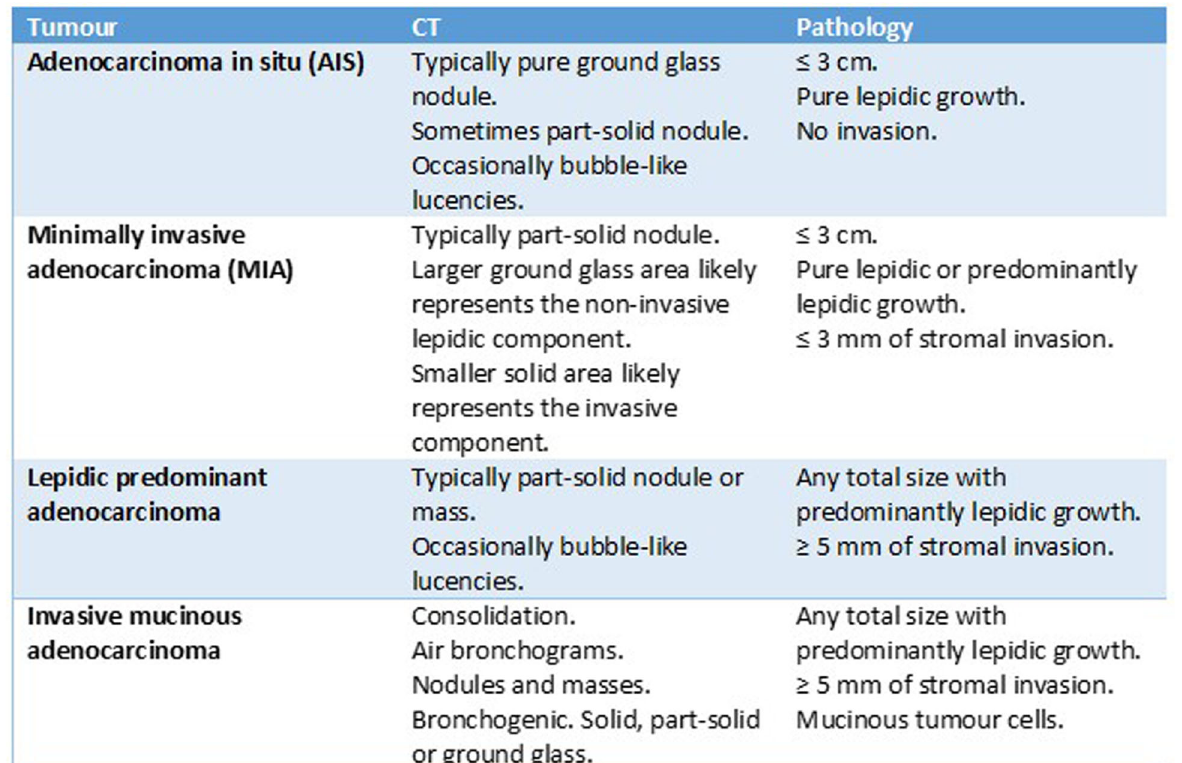
Table 1 Radiological and pathological features of the lung adenocarcinoma